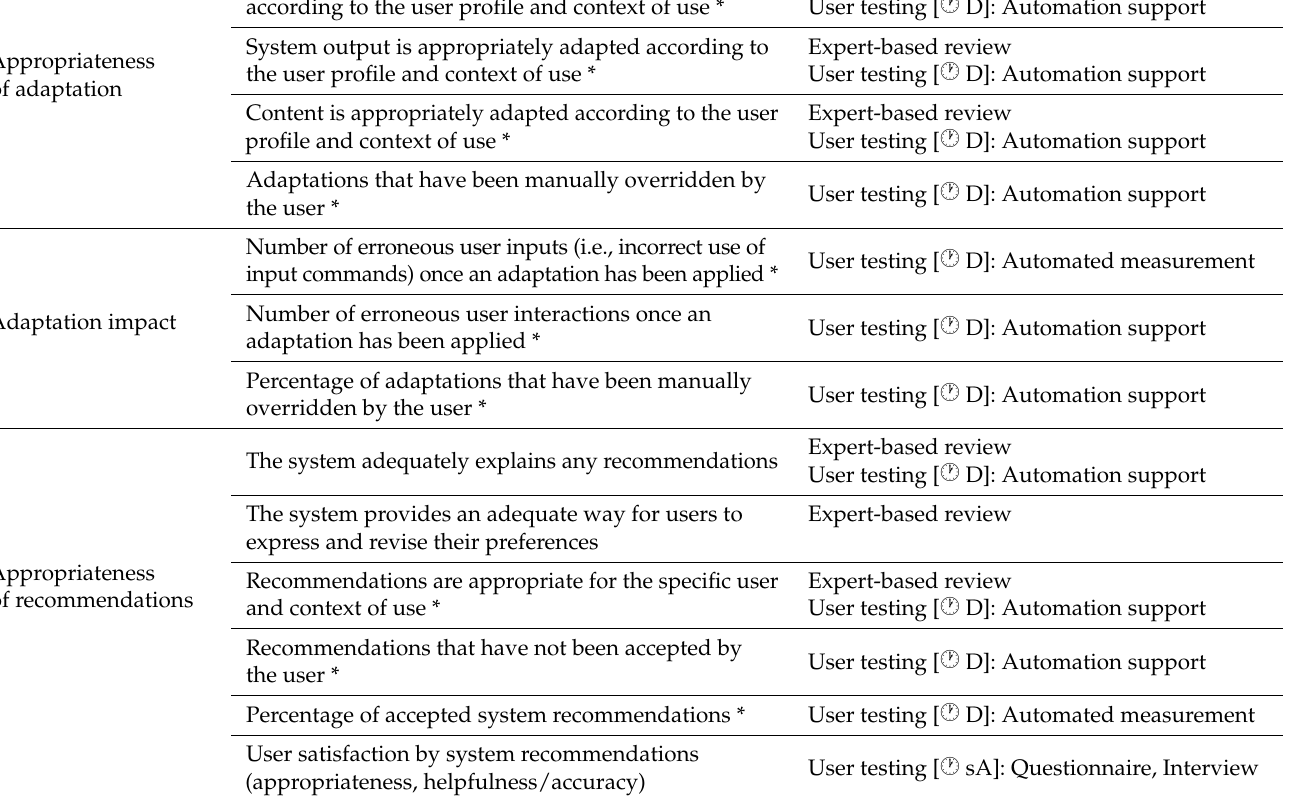
Table 1. The UXIE framework: concepts, attributes, metrics and methods. Asterisk (*) denotes metrics that are novel in the UXIE framework.